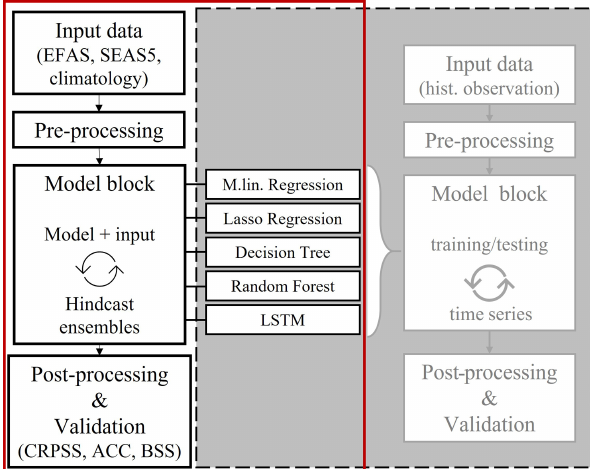
Figure 1. Schematization of a hybrid hindcast framework high- lighted in a red frame, with the grey box indicating a model frame- work previously developed by Hauswirth et al. (2021) and used as a base for the model